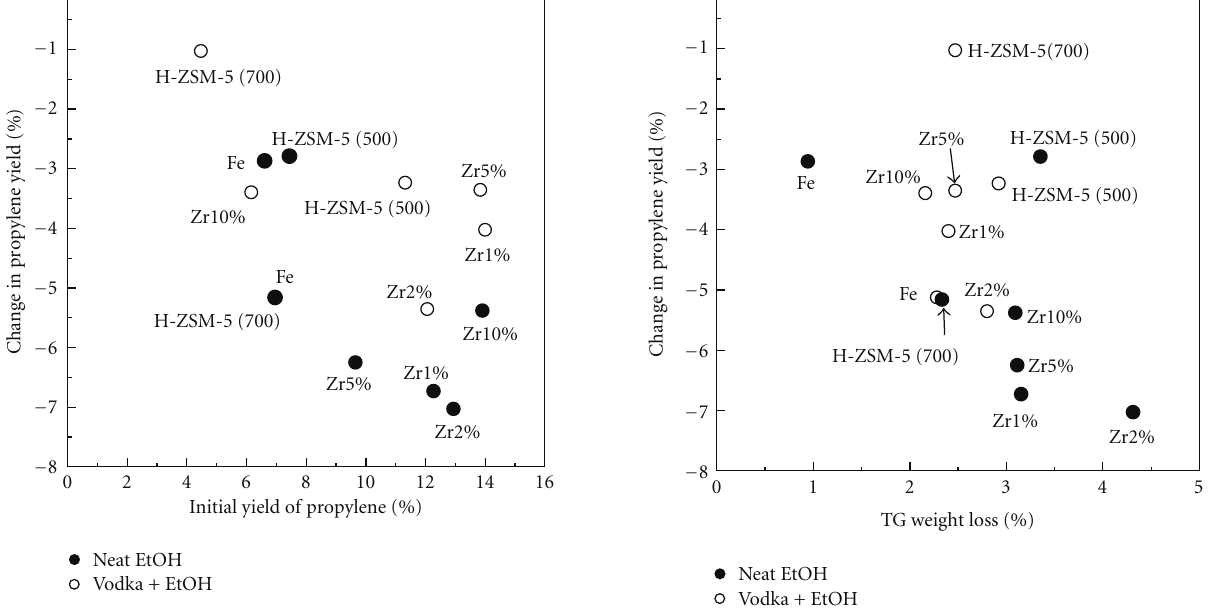
Figure 2: Plots of TG weight loss versus the change in propylene yield over H-ZSM-5 and (Fe or Zr)/H-ZSM-5